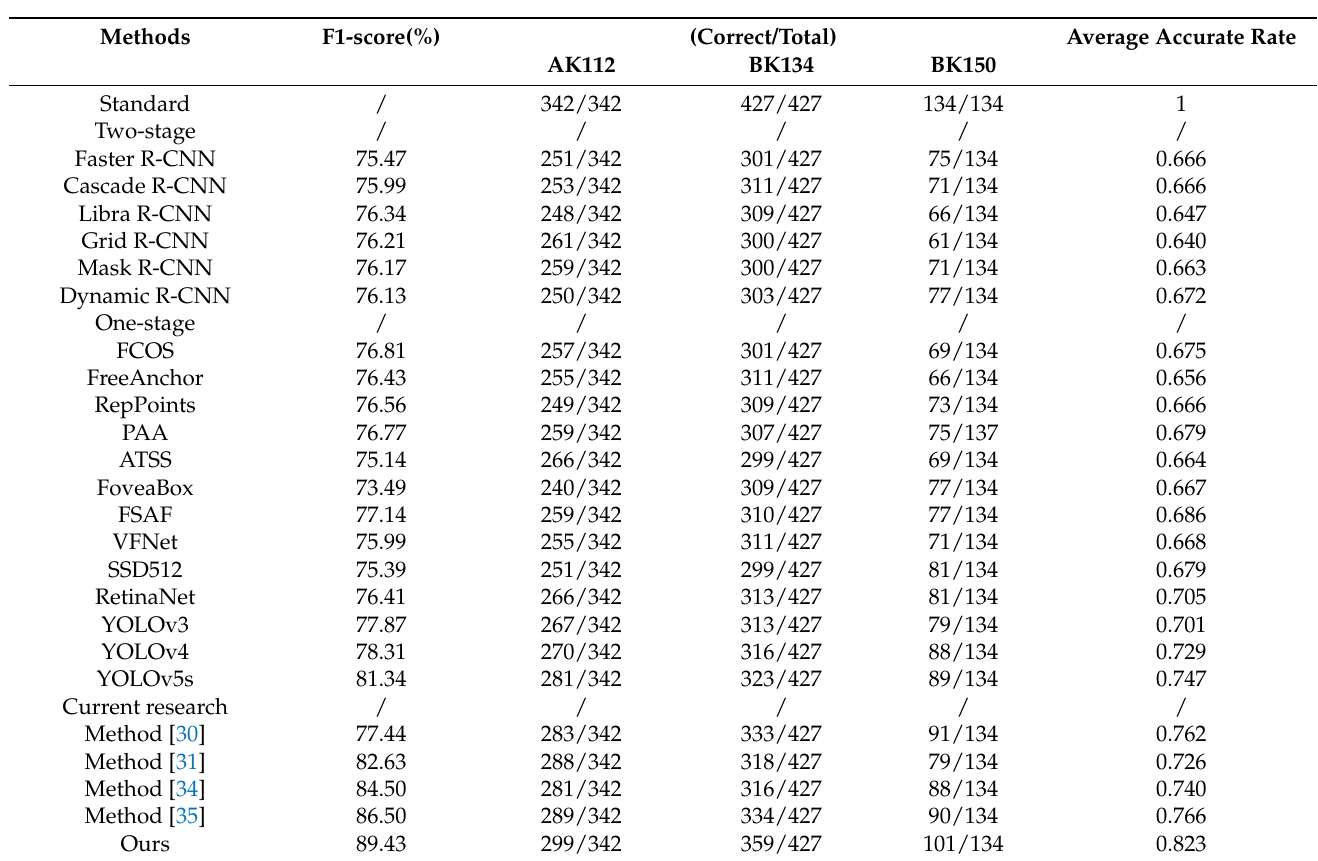
Table 8. Performance comparison of different